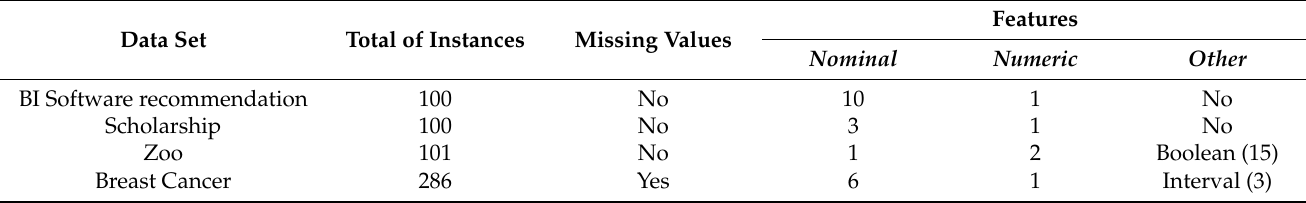
Table 4. Data sets used for the